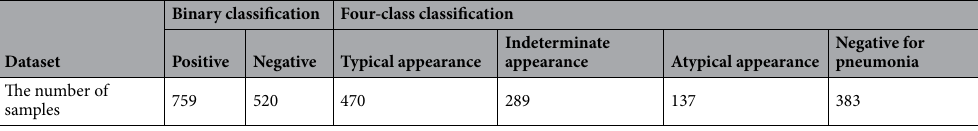
Table 1. Datasets used for